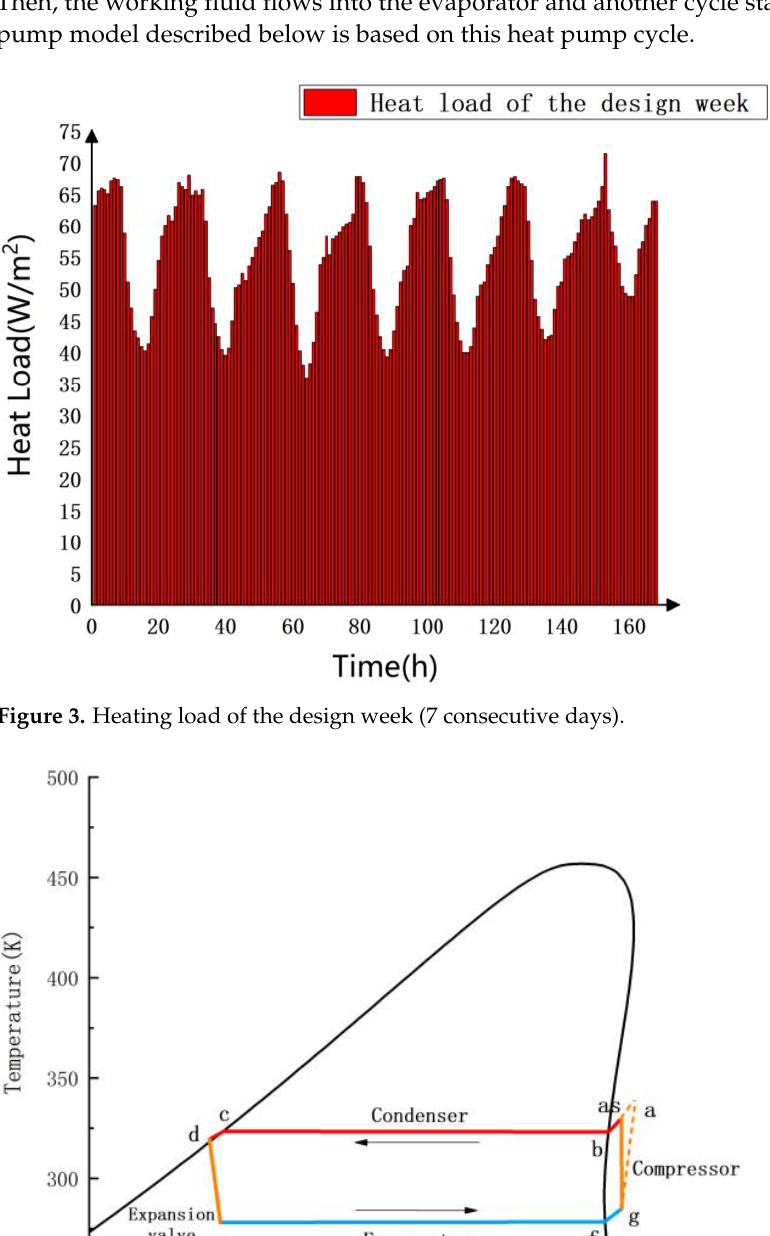
Figure 3. Heating load of the design week (7 consecutive days).